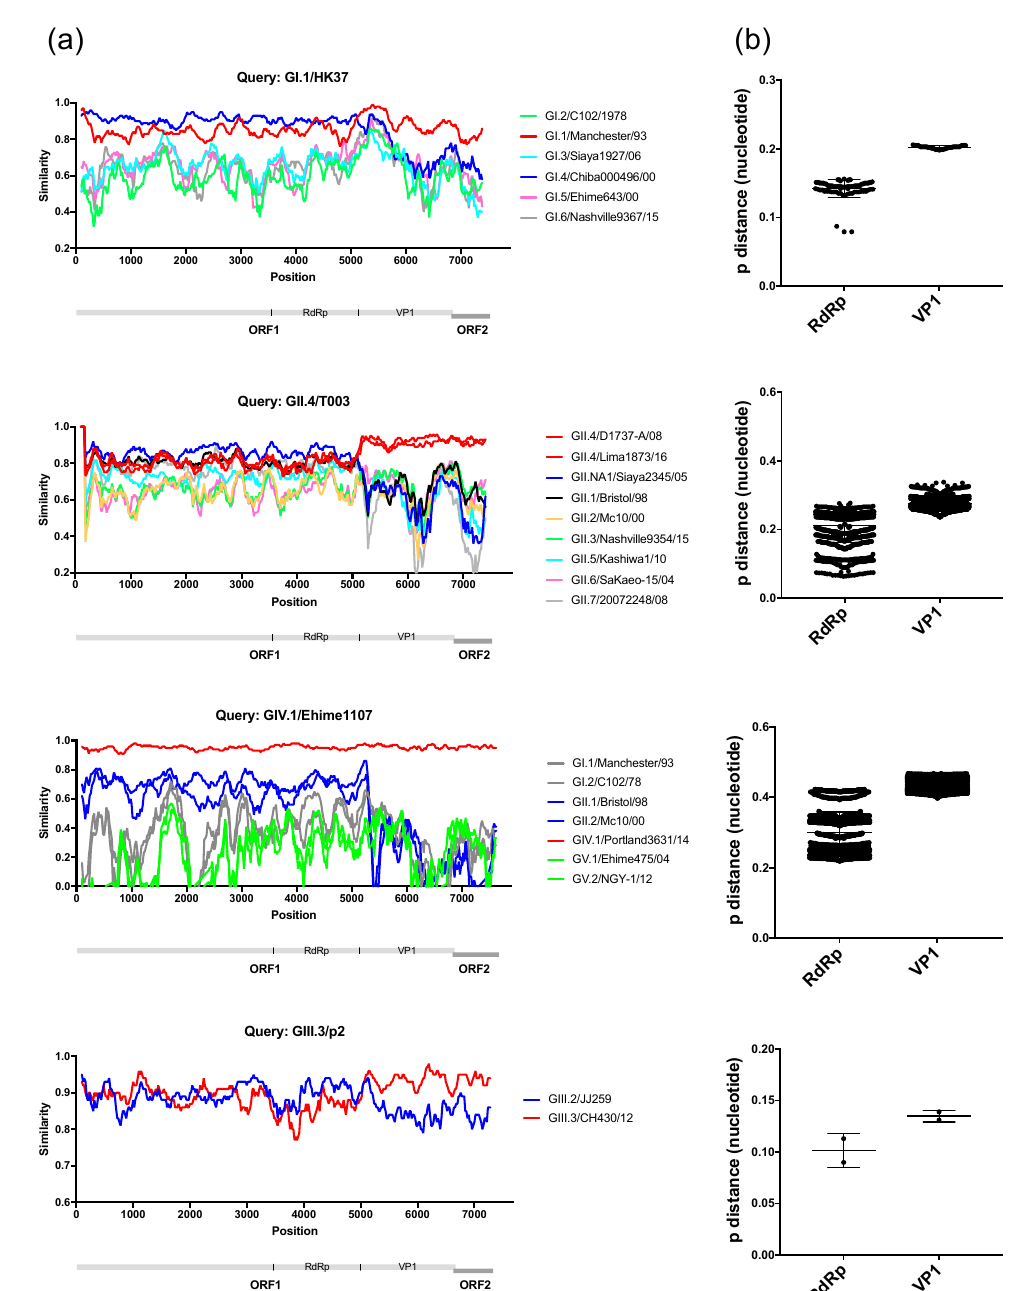
Figure 7. Genomic analyses of putative recombinant sapoviruses present limited evidence of recombination at the RdRp-VP1 boundaries. ( a ) Site-by-site nucleotide similarity analyses of four strains (GI.1/HK7 [MN794208], GII.4/T003 [MN794218], GIV.1/Ehime1107 [DQ058829] [6], and GIII.3/p2 [KX688107] [9]) that presented differences in the phylogenetic clustering when using RdRp- or VP1-encoding regions. ( b ) Inter-genotype/genogroup nucleotide substitution differences among the two genomic regions; RdRp and VP1. The VP1-encoding region presented a higher number of substitutions between the different genotypes/genogroups. Note the lack of both parental strains for the putative recombinant strains.